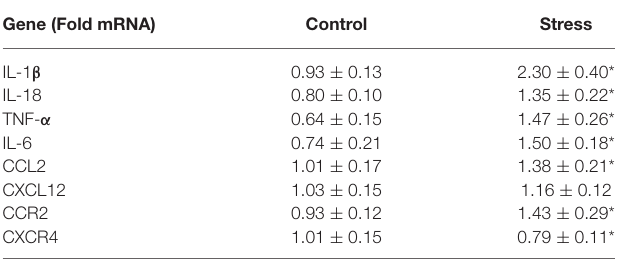
TABLE 1 | The effect of prenatal stress on the expression of pro-inflammatory cytokines: IL-1 β , IL-18, TNF- α , IL-6, chemokines: